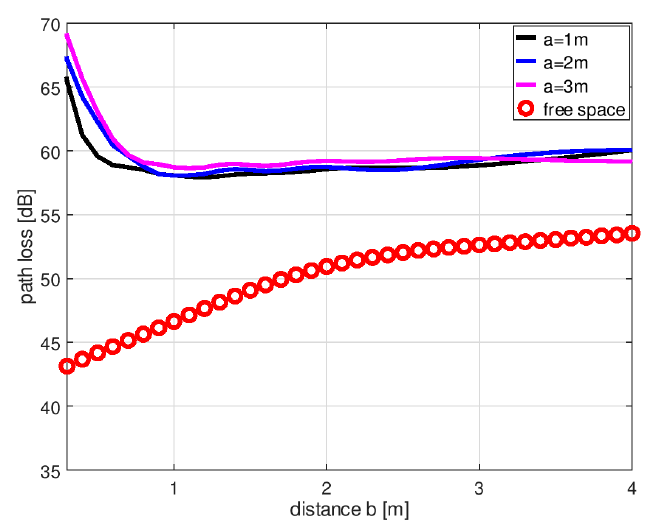
Figure 4. Path loss between transmitting and receiving dipoles simulated in XFdtd™ program as a function of receiving antenna distance b defined in Figure 2. Results for free space (no human body model and parameter a equal to 2 m) and for the shadowed case with different transmitting antenna spacings ( a = 1, 2, 3 m).